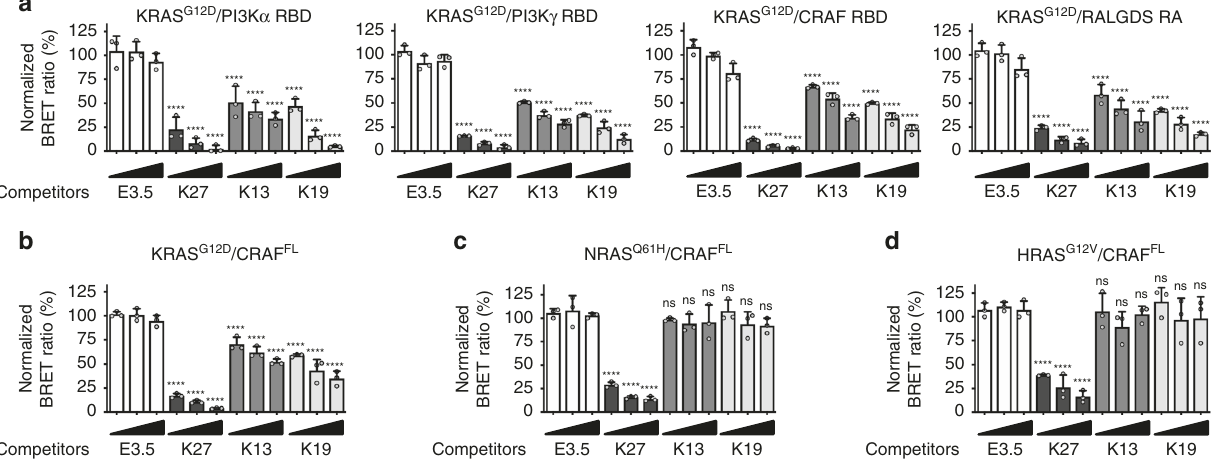
Fig. 4 K13/K19 prevent KRAS/effector interactions in cells. a BRET competition assays between KRAS G12D /effector domain interactions and the DARPins used as competitors. The effector domains used were PI3K α RBD, PI3K γ RBD, CRAF RBD and RALGDS RAS-associating (RA) domain. b – d BRET competition assays between CRAF FL /KRAS G12D ( b ), NRAS Q61H ( c ) and HRAS G12V ( d ) interactions with the DARPins used as competitors. E3.5 is a negative control, and DARPin K27 is a positive control. Statistical analyses in a – d were performed using a one-way ANOVA followed by Dunnett ’ s